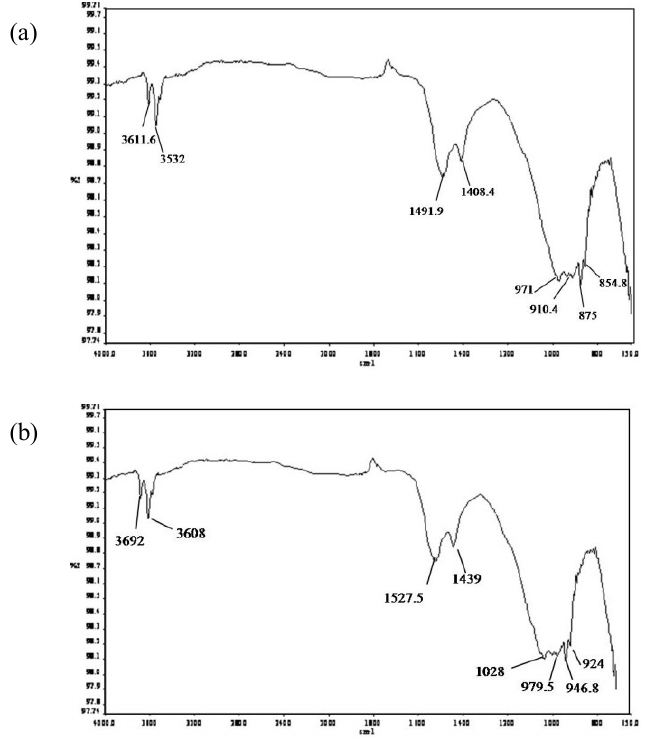
Figure 4. FTIR spectra of EAFS (a) before adsorption (b) after